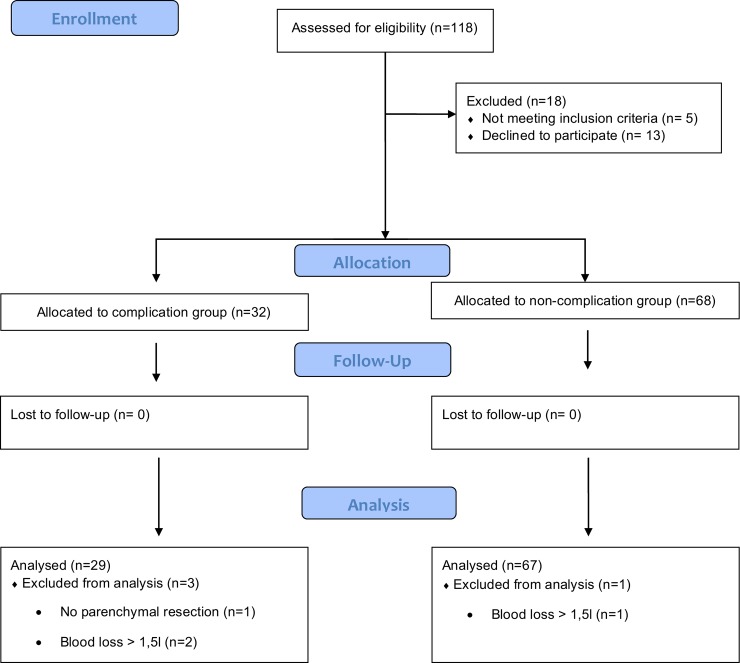
CONSORT flow chart.